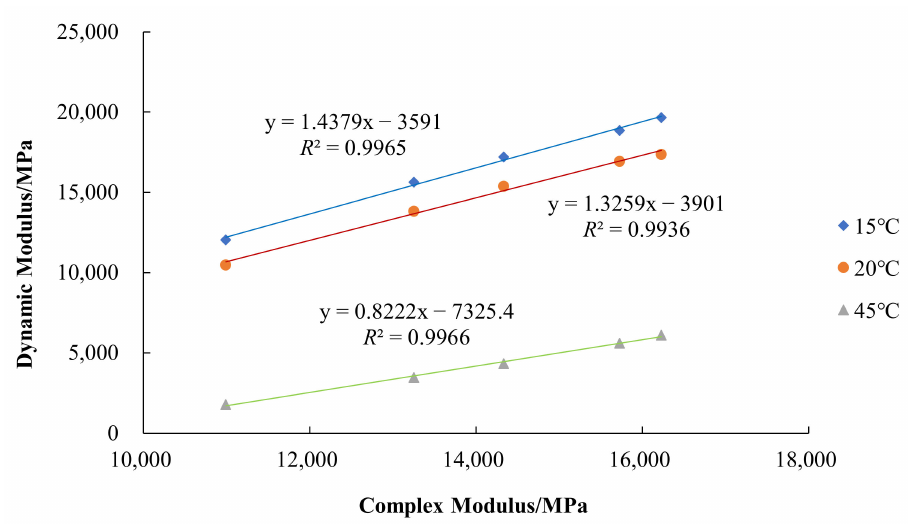
Figure 10. HMAC-20-France